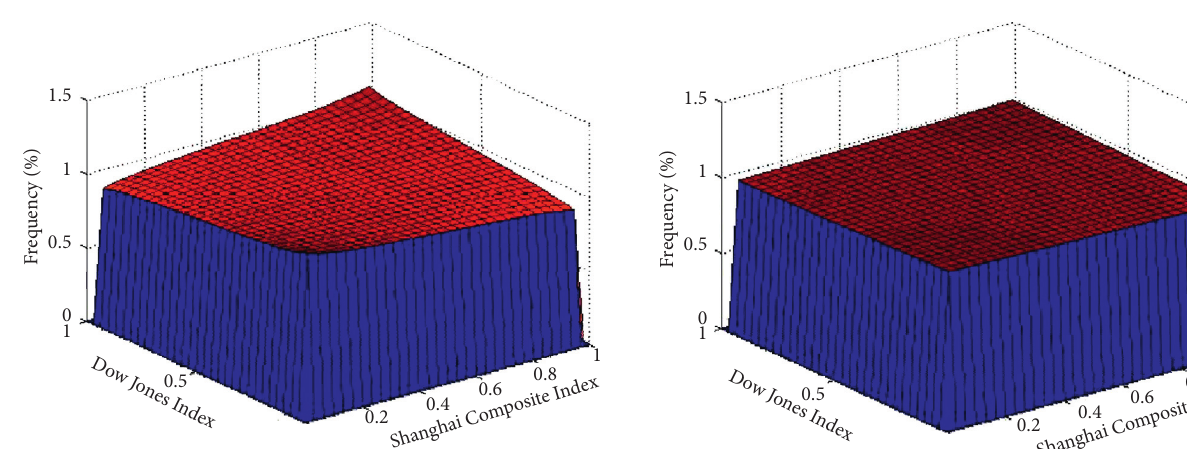
Figure 7: Frank Copula distribution of SSE index and Dow Jones Index extreme volatility series based on B segment weekly